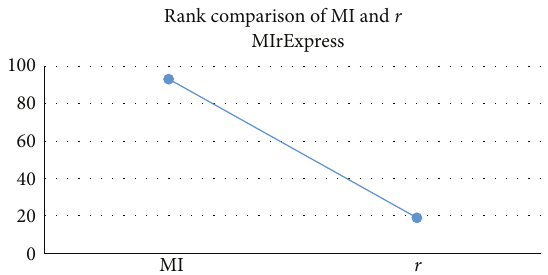
Figure 4: Page for pairwise correlation analysis. The scatter diagram of probe set pair is omitted which appears as Figures 3(a), 3(b), 3(c), 3(d), and 3(e). The species is “human”; the dataset is “CD3+ T cell”; for Gene A, the probe set ID is “1007 s at” and the gene symbol is “DDR1”; for Gene B, the probe set ID is “1053 at” and the gene symbol is “RFC2.” The Pearson’s 𝑟 value is − 0.05538, the MI value is 1.04368, and the MIr value is 0.36477 for their